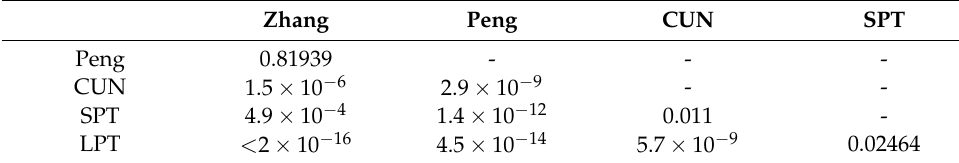
Table 1. Pairwise p -values of Nemenyi [64] test for CPU runtime. Zhang Peng CUN SPT Peng 0.81939 - -